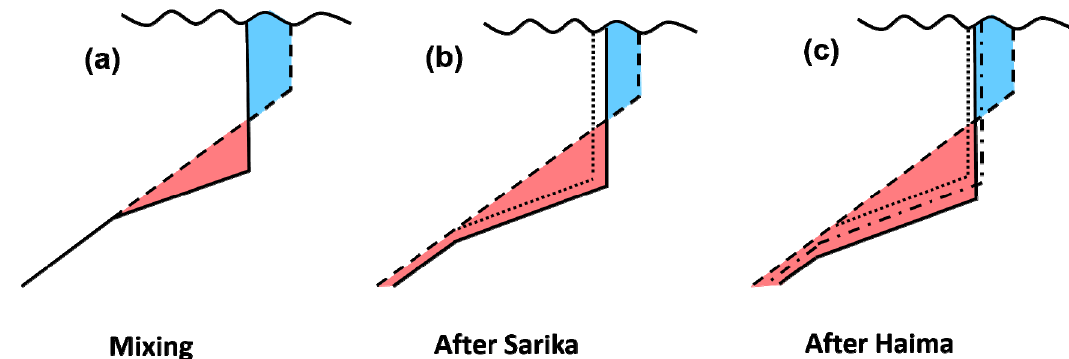
Figure 13. Sketch of the vertical temperature profiles at Station 2 before (dashed lines) and after (solid lines) ( a ) only mixing, ( b ) Sarika, and ( c ) Haima. The dotted lines in ( b ) and ( c ) indicate the temperature profiles caused by only mixing, while the dot-dashed line in ( c ) indicates that caused by Sarika. The red shading indicates the warming anomaly, and the blue shading the cooling